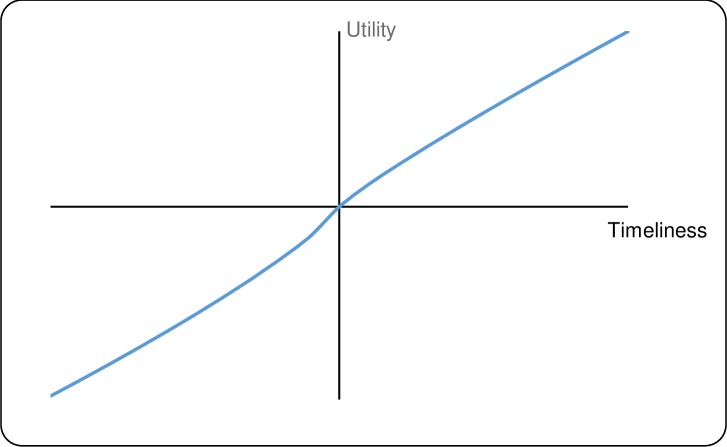
Plot of median utility (gains and losses) for timeliness.